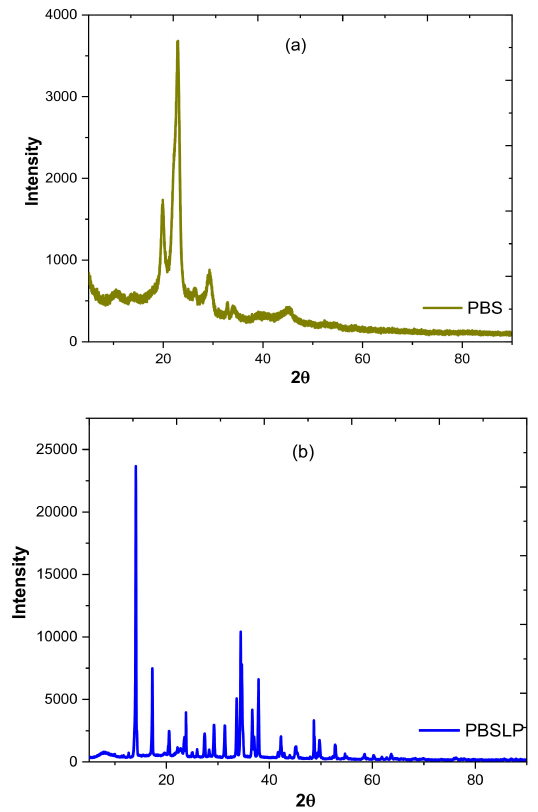
Figure 4. Di ff ractogram of ( a ) PBS and ( b )